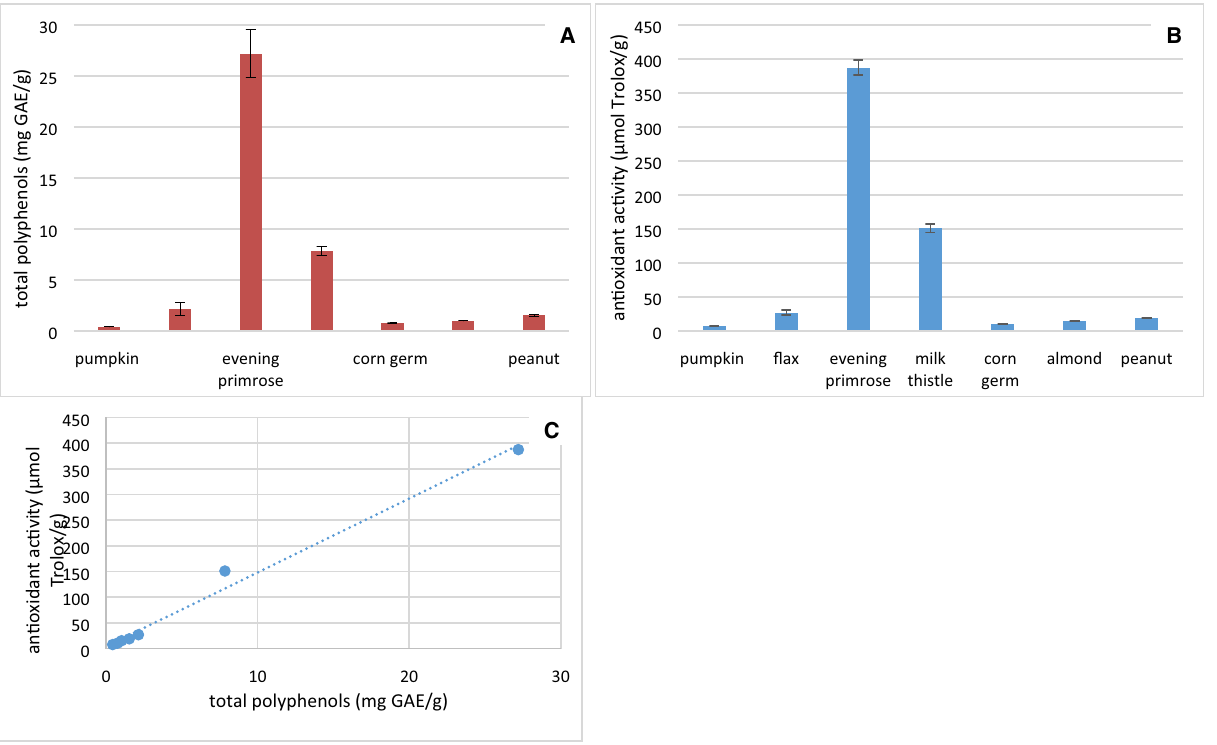
Figure 1. Total polyphenols ( A ) content, antioxidant activity (ABTS˙ + ) ( B ) and correlation between total polyphenols content and antioxidant activity ( C ) of selected cold-pressed seed